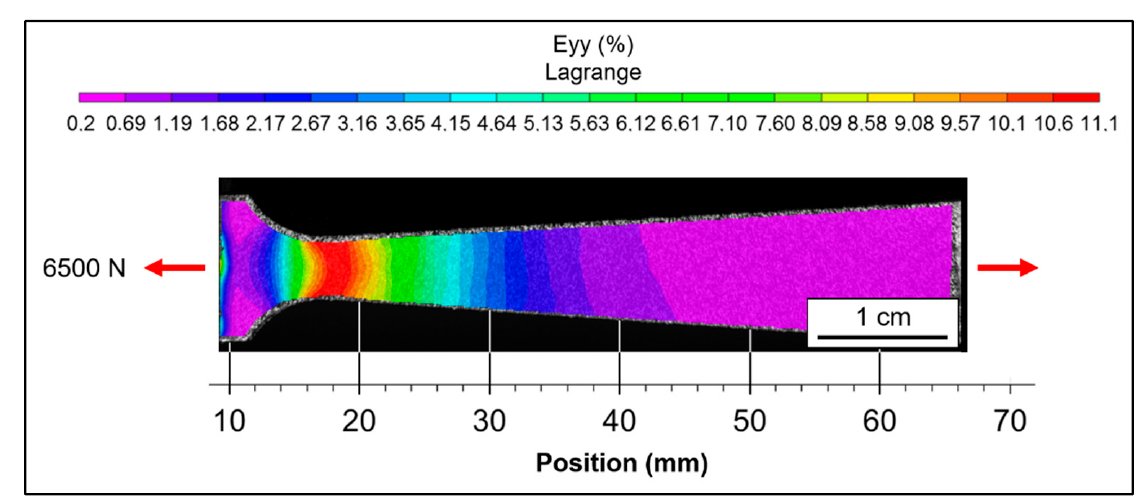
Figure 17. Total strain field along the tensile direction obtained by digital image correlation on a trapezoidal heat-treated L-PBF sample for a 6500 N force applied in the thinnest section (10.2 mm 2 ). Here, 11% maximum plastic deformation was measured in the thinner zone at a position around 18